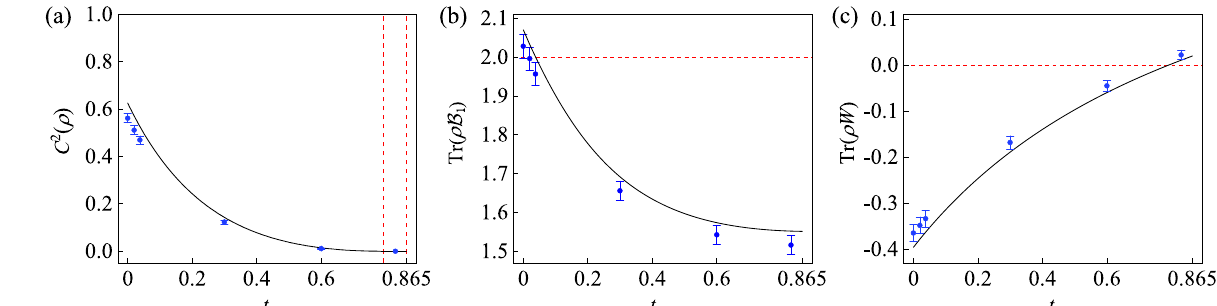
Fig. 3 Experimental results for detecting weak entanglement. a Squared concurrence versus the parameter t of a two-qubit state. For small 0 ≤ t < 0.791, ρ is entangled as squared concurrence C 2 ( ρ ) > 0. For 0.791 ≤ t ≤ 0.865, ρ is separated as C 2 ( ρ ) = 0. b Violations of the CHSH inequality versus t . The other parameters of the state and the detection ef fi ciency are fi xed as s = 1/50, τ = 1/2, and η = 3/4. Bell nonlocal states with 0 ≤ t ≤ 0.038 violate the CHSH inequality. c Values of the entanglement witness Tr( ρ W ) versus t . Entangled Bell local states with 0.038 < t < 0.791 can be indicated via the entanglement witness. Symbols are experimental data, which agree with their theoretical predictions (solid